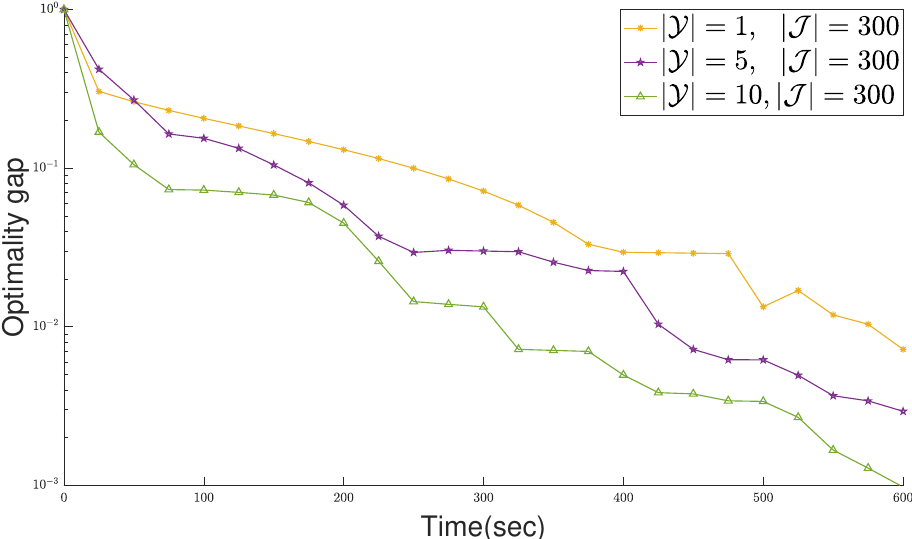
Figure 8. The Impact of the number of network domains on the